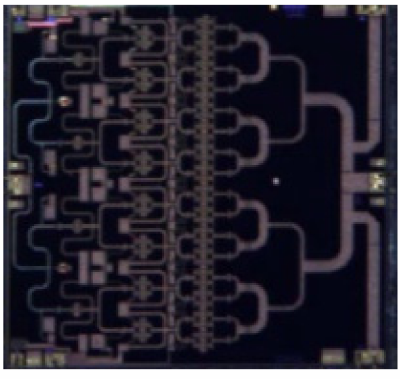
Figure 15. The 3-stack 16-combined PA150 nm GaAs pHEMT